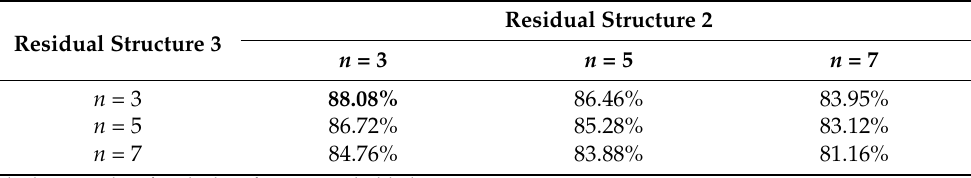
Table 4. The recognition accuracy of different network structures on dataset 3a (n represents the size of the convolutional